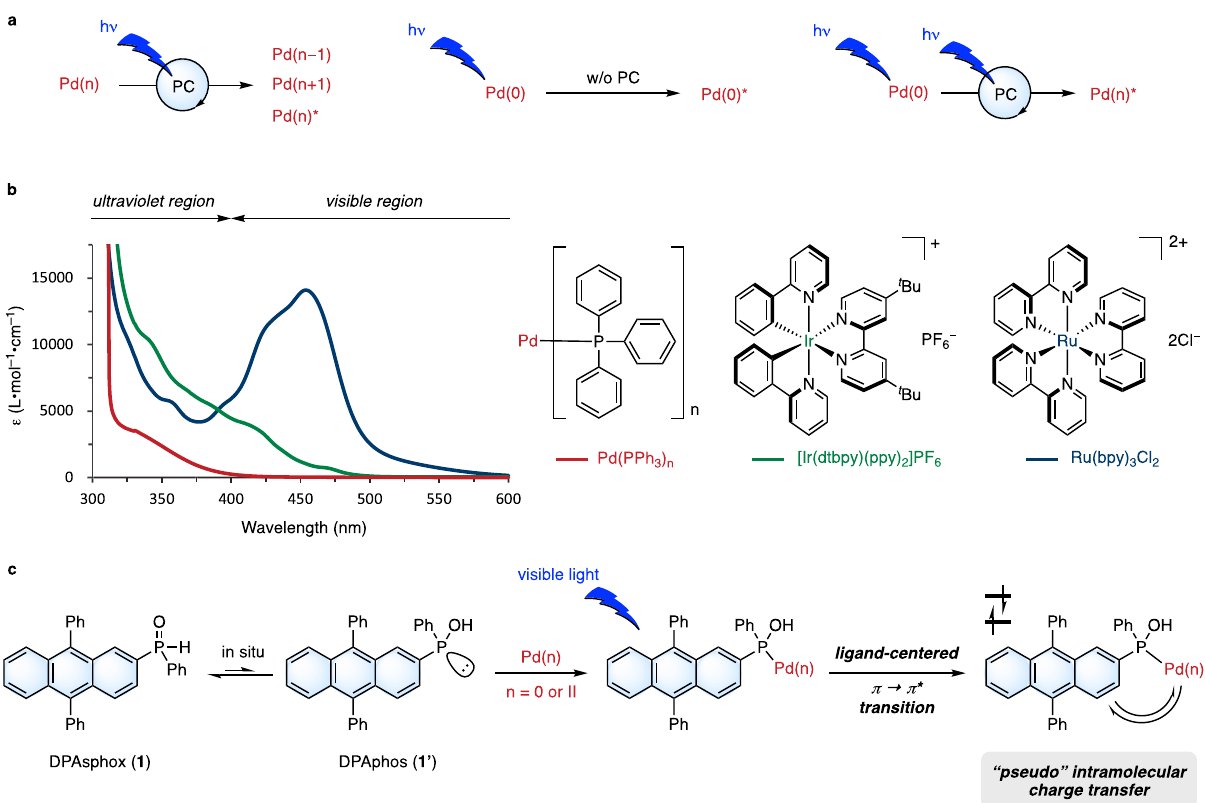
Fig. 1 Pd-catalyzed photoreactions. a Classi fi cation of photo-induced Pd-catalyzed reactions. b Absorption coef fi cient of Pd(0) complex is smaller than Ir and Ru photoredox complexes in visible region. UV-Vis spectra were measured in N , N -dimethylacetamide (DMA). c Concept of visible-light – activated secondary phosphine oxide ligand (DPAsphox ( 1 )). PC photocatalyst, dtbpy 4,4'-di-tert-butyl-2,2'-bipyridyl, ppy 2-phenylpyridine, bpy